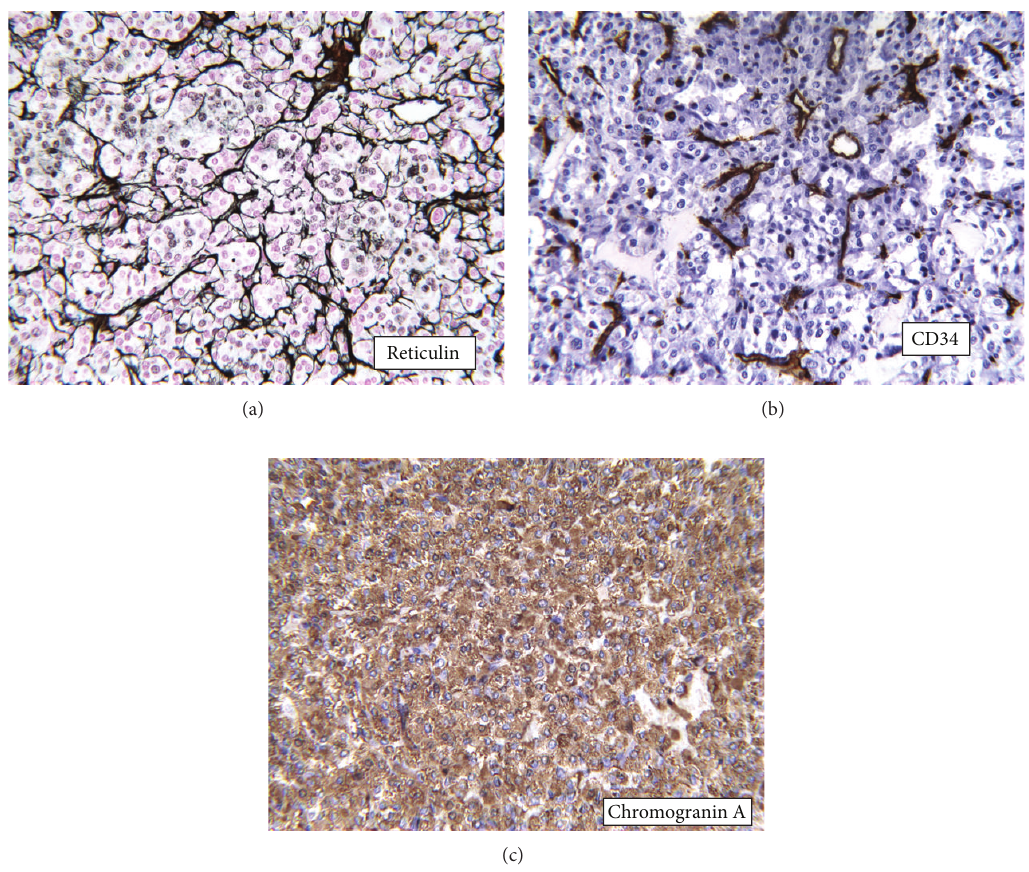
Figure 2: (a) Clusters of cells surrounded by reticulin fibrosis known as Zellballen arrangement, typical of paraganglioma. (b) CD34 immunostain marking the numerous small capillaries in the tumor. (c) Chromogranin A immunohistochemical